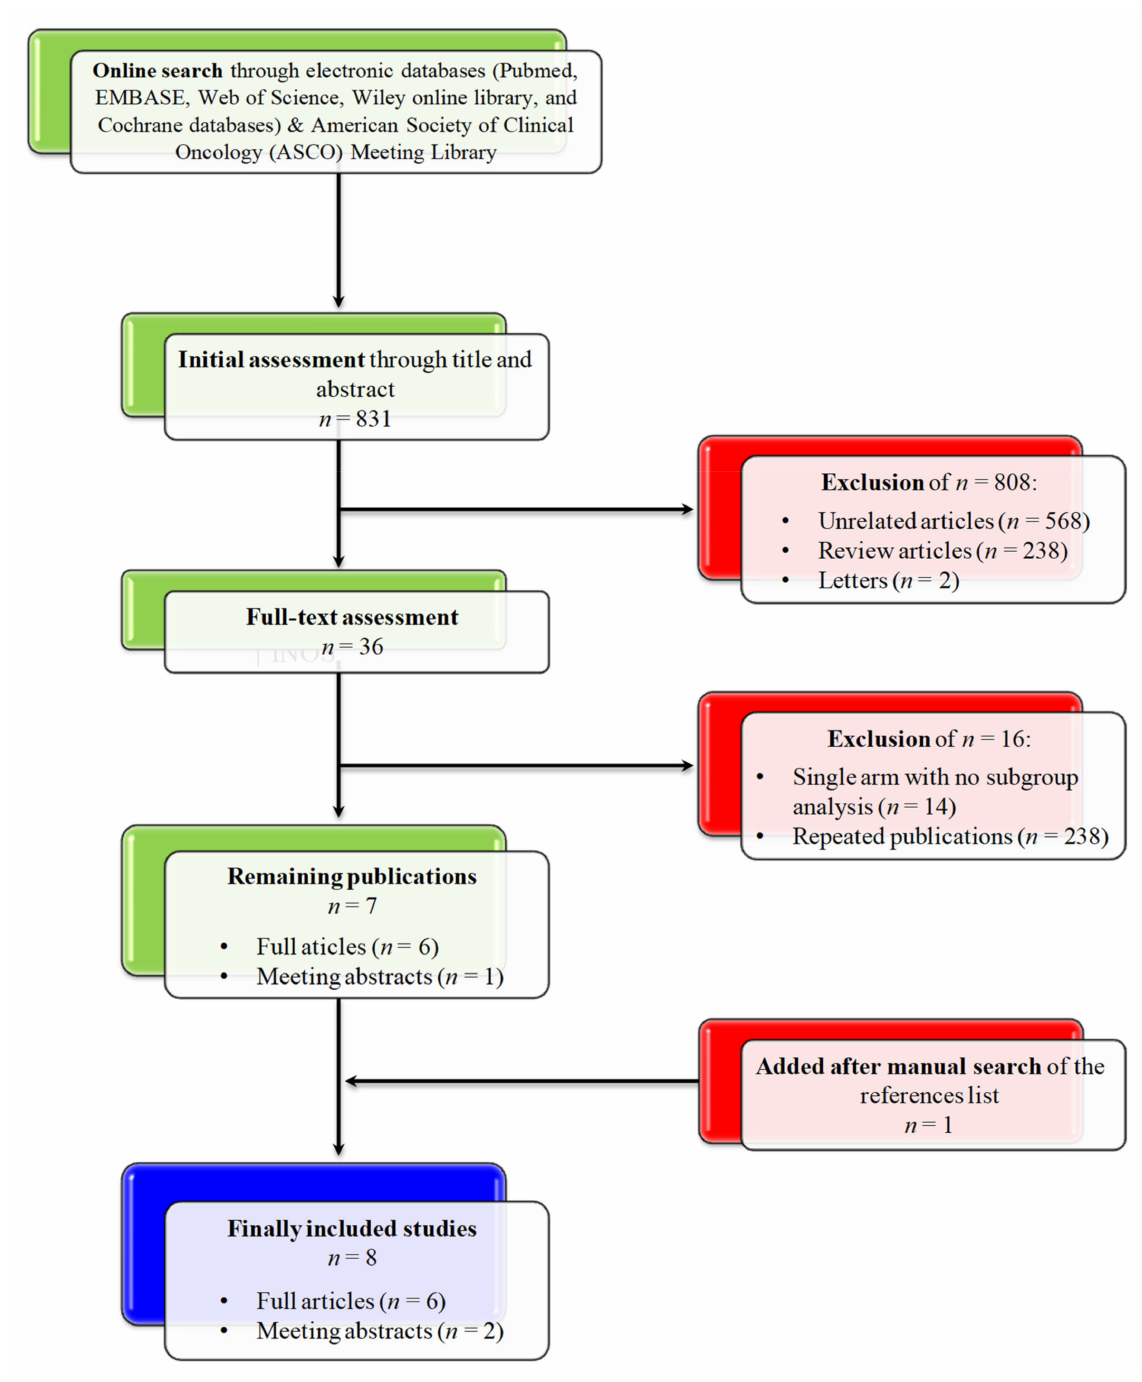
Figure 1. CONSORT diagram for the screening and selection processes of the included